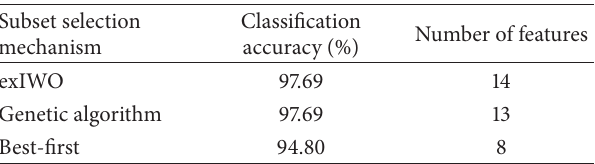
Table 7: Evaluation of the subset selection mechanisms for the mocap data.